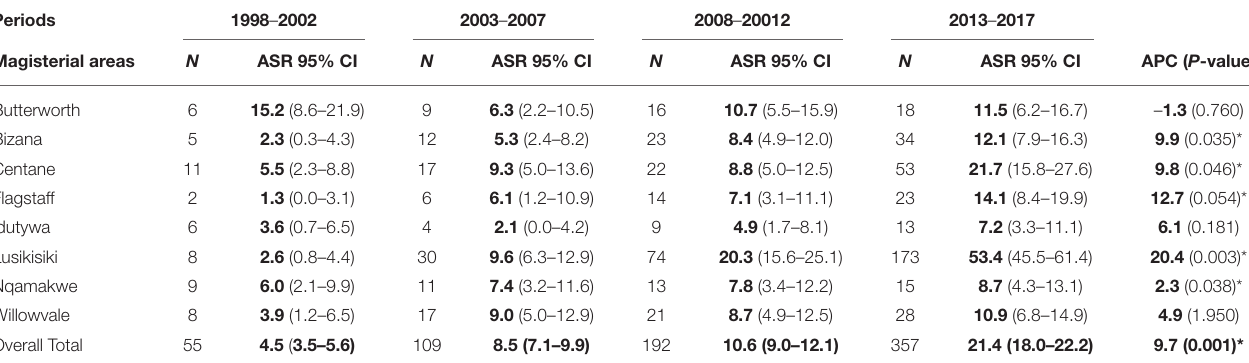
TABLE 2 | Age-standardized incidence rates and annual percentage change by magisterial